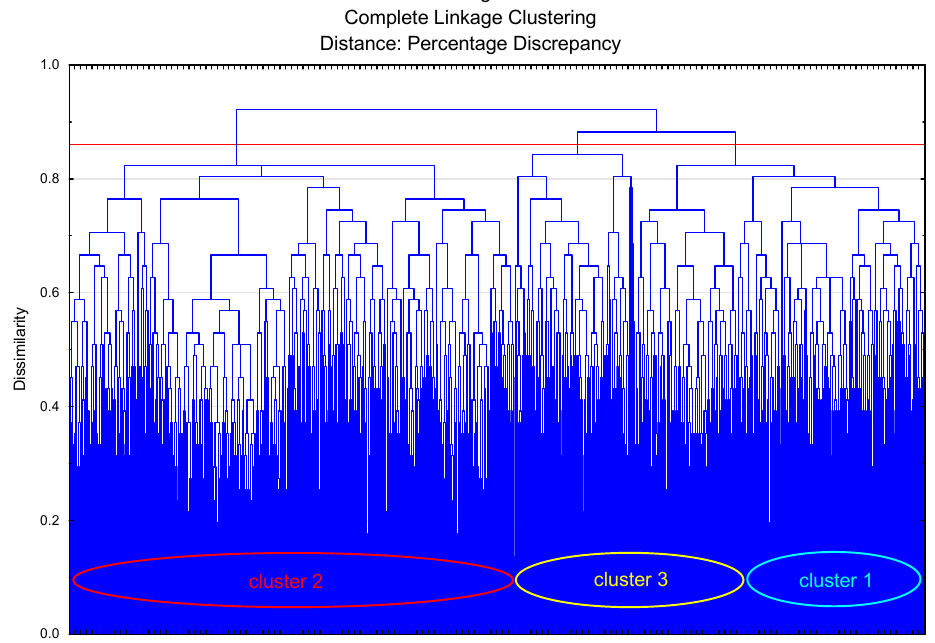
Figure 3. Chart agglomeration of cases.